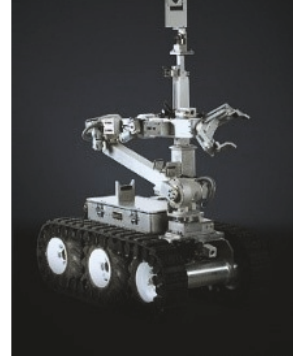
Figure 2: V2 robot.